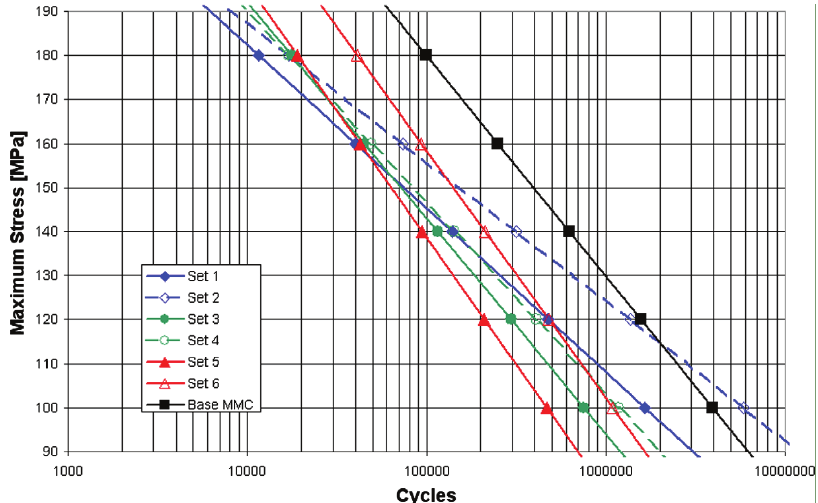
Figure 14 . 50% failure probability curves of friction stir processed 22 vol % Al reinforced AA6061 composites under different processing conditions (after Minak et al. [99]).